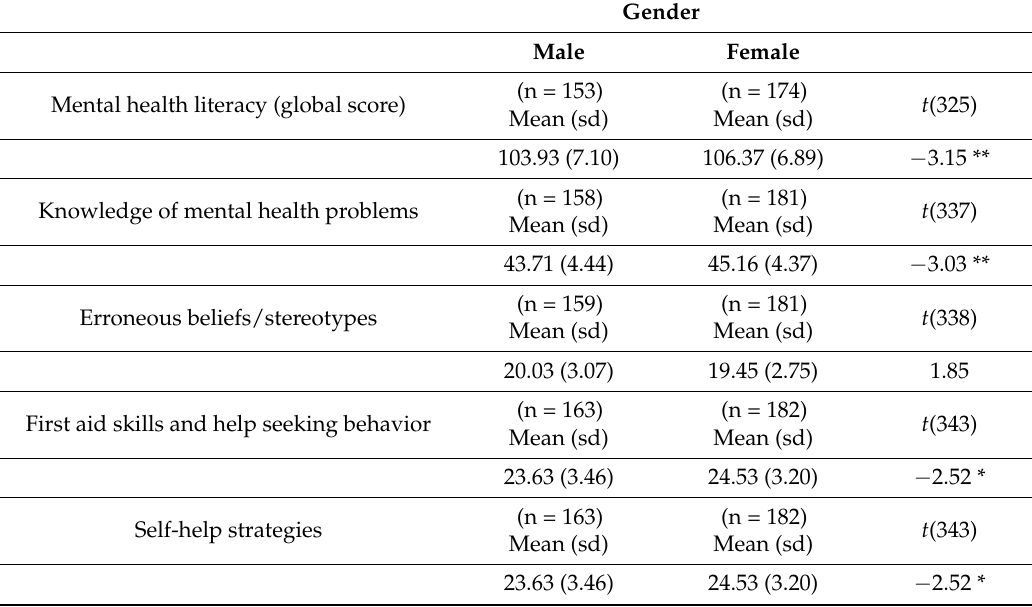
Table 4. Gender differences in mental health literacy (MHLq global score and